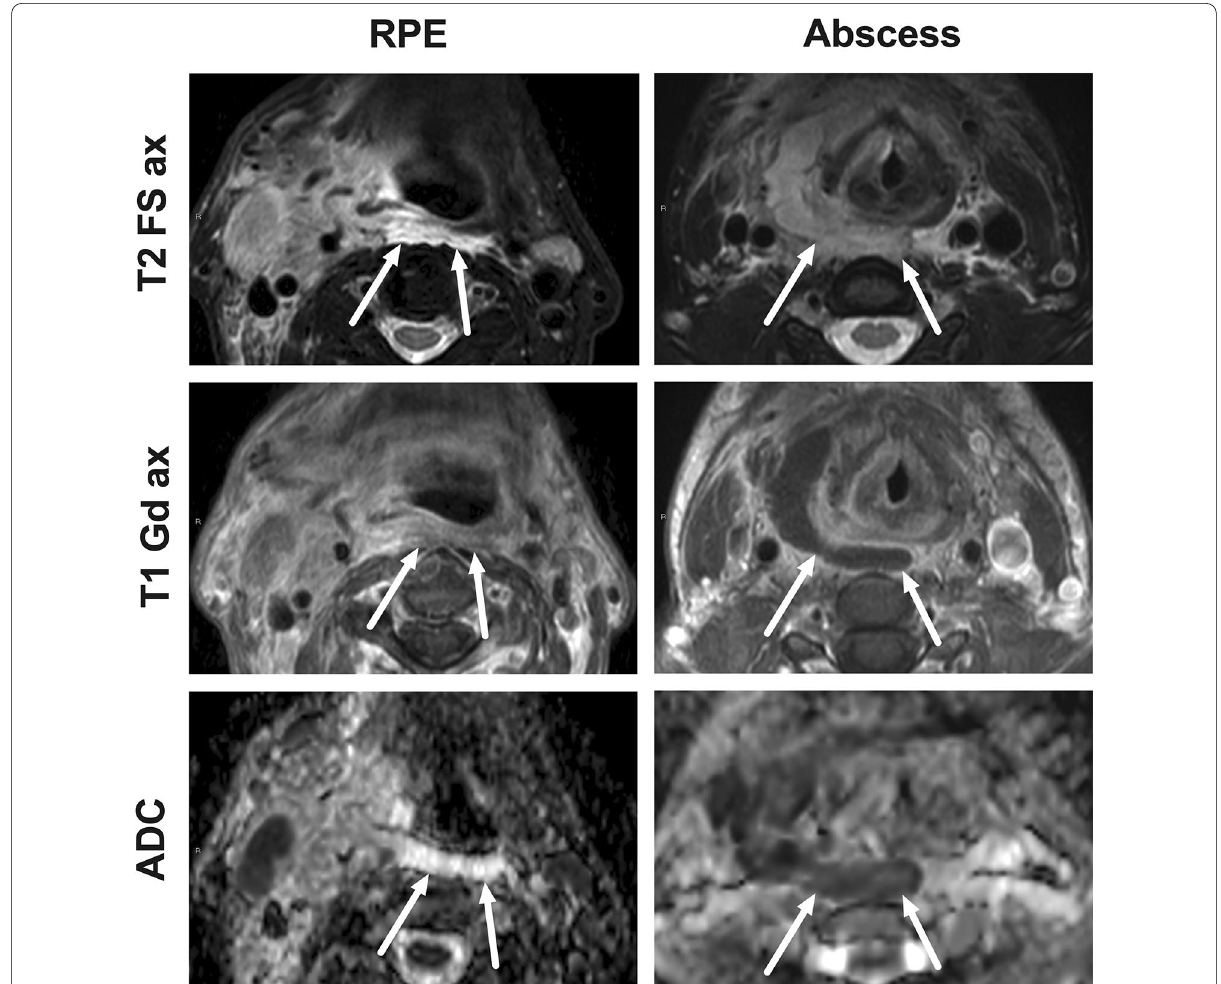
Fig. 12 Differentiating between RPE and a retropharyngeal abscess: RPE is usually very bright on T2-weighted images, whereas abscess has an intermediate signal. Enhancement of RPE is variable, whereas an abscess does not enhance. Finally, the key is ADC: bright in RPE, dark in abscess. Arrows denote collections. Image modified from ref.